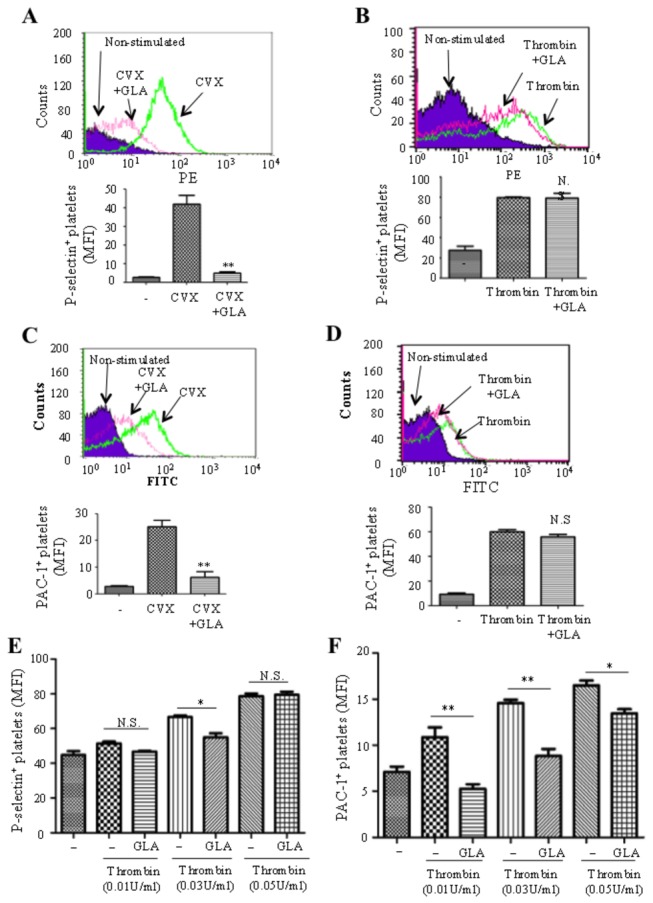
Effects of GLA on single-platelet activation.Gel-filtered platelets (2.5×108/ml) were pre-incubated with vehicle (DMSO) or GLA (0.5 μg/ml) for 10 min in the presence of PE-conjugated P-selectin antibody or FITC-conjugated PAC-1. Samples were then challenged with CVX (0.2nM) (A, C) or thrombin (0.1U/ml) (B, D) and incubated for 10 min. P-selectin expression (A, B) and PAC-1 binding (C, D) were monitored by flow cytometry. Similarly, using the effective inhibitory dose of GLA (0.01μg/ml), P-selectin secretion (E) and integrin activation (F) induced by lower doses of thrombin were tested. Data plotted are means ± standard errors of three individual experiments. *P < 0.05. **P < 0.01. N.S., not significant compared to vehicle control.. The statistical significance was determined by one-way ANOVA analysis of variance with the Bonferroni post test.